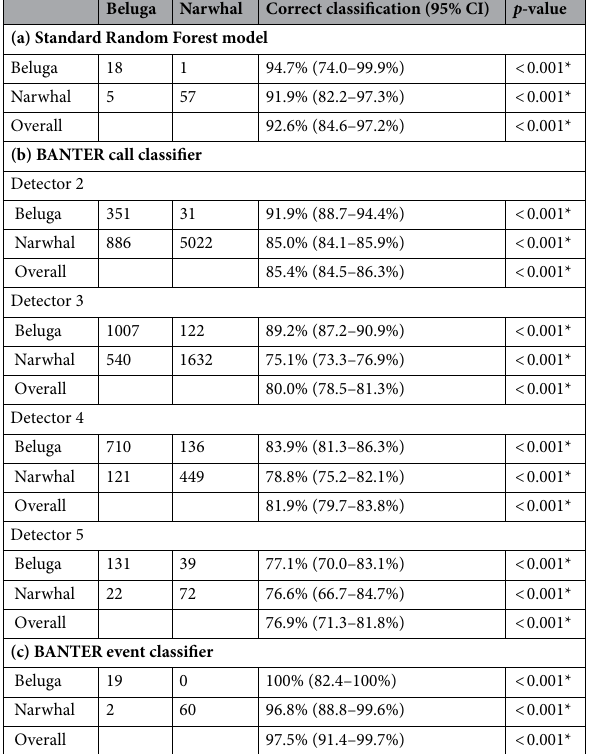
classification of individual clicks (Fig. 4d). However, since the event classifier uses mean assignment probabilities from each detector classifier as predictors, the most important variables for the detector 2 and 3 classifiers are not necessarily important variables for the event classifier. Examination of the vote distributions for the detector 2 and 3 call classifiers revealed that the detector 2 call classifier produced confident species classifications (i.e., the majority of samples were classified at high probability) compared to the detector 3 classifier (Supplemen- tary Fig. S2). Overall, the BANTER model demonstrated strong predictive power with only two narwhal event misclassifications (Table 3; Fig. 4c). For correctly classified events, the model had high confidence for its species assignment evidenced by its vote distribution (Supplementary Fig. S3). The correlation test to examine similarity between acoustic encounters revealed that events among different encounters were similar. A positive correlation between training confusion matrices (from models built using one encounter per species) and validation confusion matrices (from training models that predicted events from encounters not used in training model) indicated similarity between encounters. With the exception of one pair, all encounter pairs had a positive correlation and 6 of the 10 pairs had a correlation greater than 0.5 (Sup- plementary Table S4). For both the single RF and BANTER models, the majority of the predictions for beluga and narwhal acoustic events were tightly clustered (Fig. 4a,c). These tightly clustered, correctly classified events were marked by clear differences between beluga and narwhal spectral characteristics. Beluga average spectra tended to be smoother, have a larger bandwidth, and higher -3 and -10 dB frequency minimums and maximums (Figs. 3a and 5a). Conversely, narwhal average spectra presented peaks and notches, a lower bandwidth, and lower frequency minimums and maximums (Figs. 3b and 5c). Average spectra from events that were misclassified and showed properties of both beluga and narwhal spectral characteristics generally had lower signal magnitudes (dB), smaller click sample sizes, and spectral variations that suggest a higher proportion of off-axis clicks (i.e., clicks not centered on the recording equipment; Figs. 3 and 5).